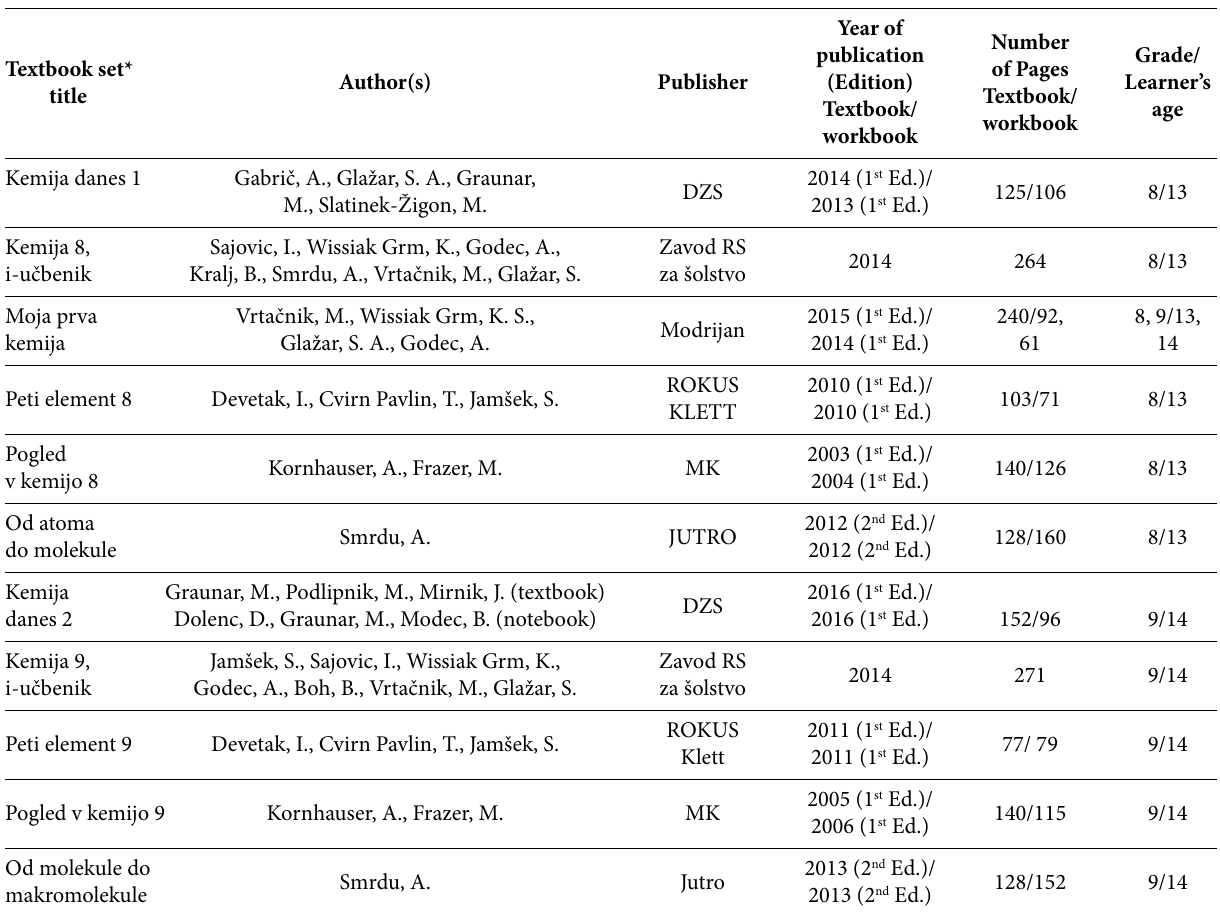
Table 1. The list of the analysed textbook